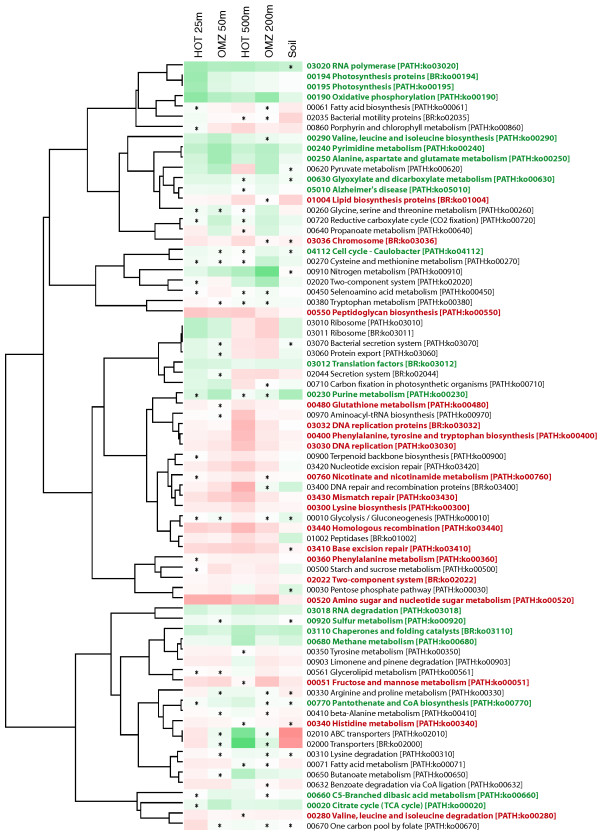
Heat map showing the proportion increase (green) or decrease (red) of KEGG k3 functional pathway abundance between expressed and non-expressed gene fractions in DNA data from five representative samples. Colored gene names mark KEGG pathways in which the direction of change was consistent across all five samples. All differences (abundance in expressed fraction versus abundance in non-expressed fraction) are significant (P < 0.0001, chi-square), unless marked with an asterisk. Only the 75 most abundant KEGG k3 pathways are shown. Genes are grouped by hierarchical clustering of Pearson correlation coefficients for each pairwise dataset comparison.